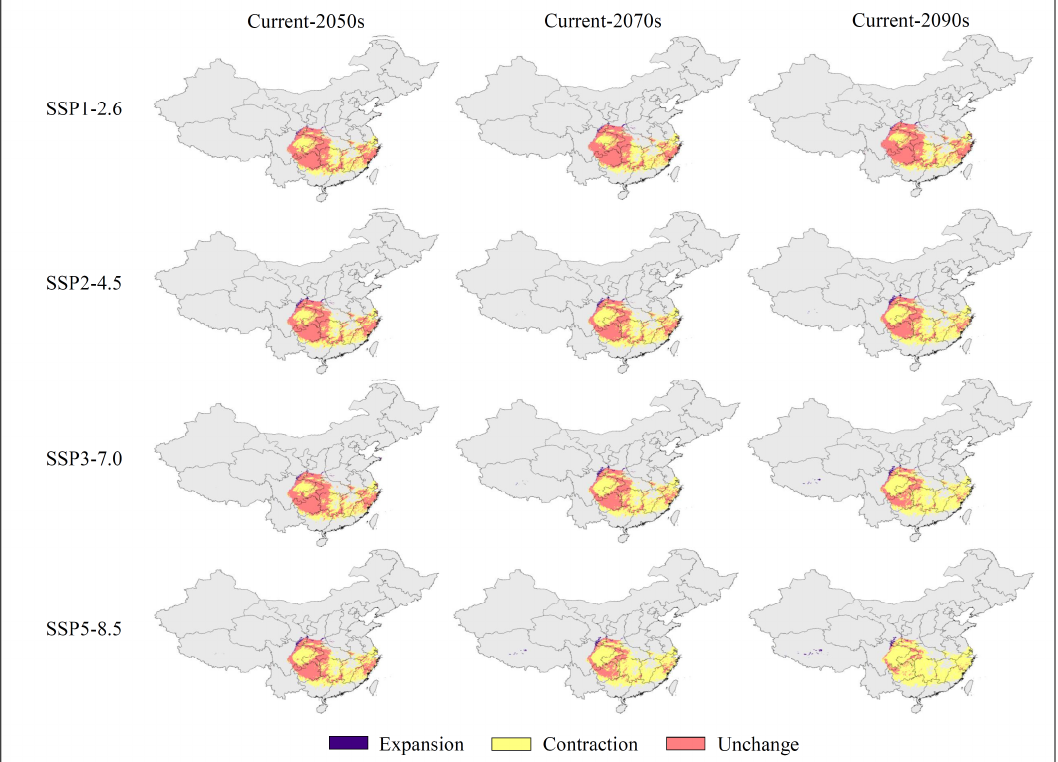
Figure 4. Changes of potential ly suitable areas of Coptis chinensis from current to future climatic conditions.